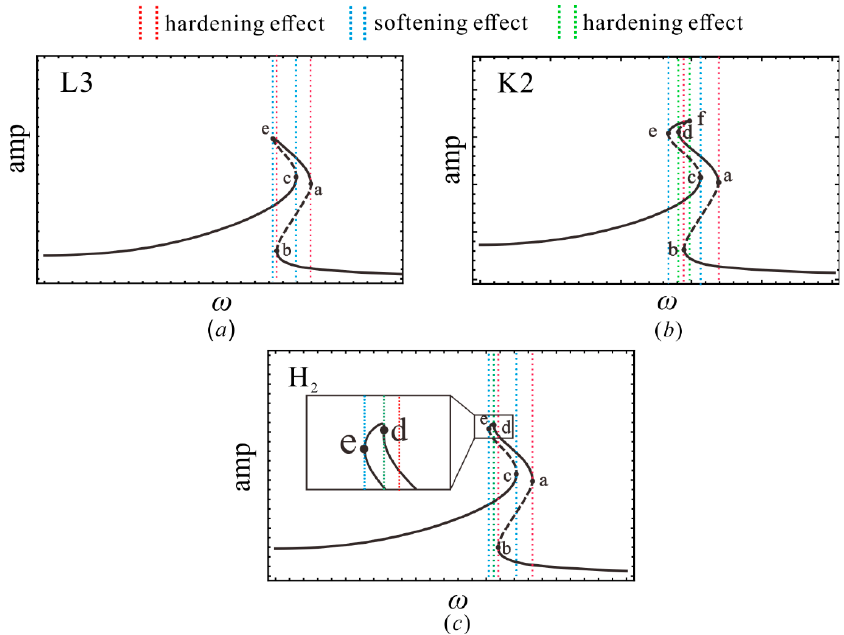
Figure 8. Amplitude ‐ frequency response curve in ( a ) region L3; ( b ) region K2; and ( c ) line H 2 , where the solid points a–f are tangent points.